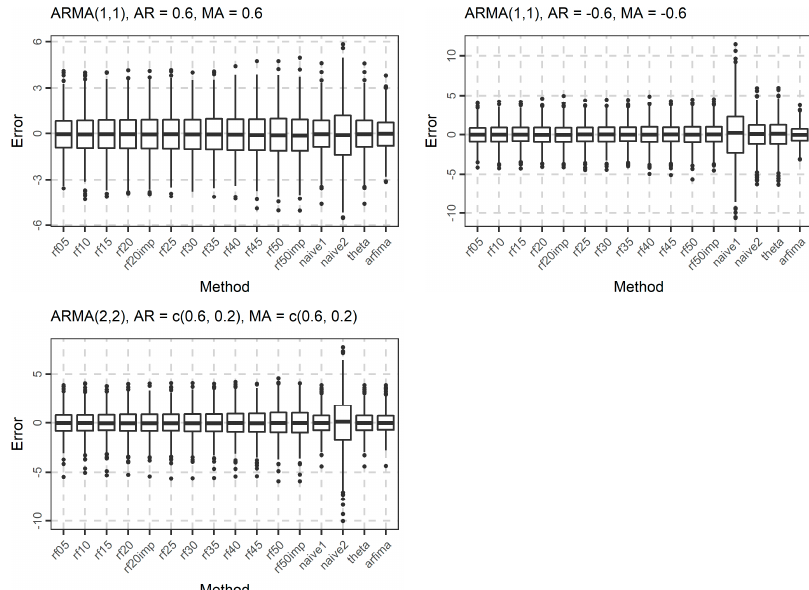
Figure 8. Boxplots of the errors when forecasting the 101st value of 1000 simulated time series from each ARMA( p , q ) model used in the present study.